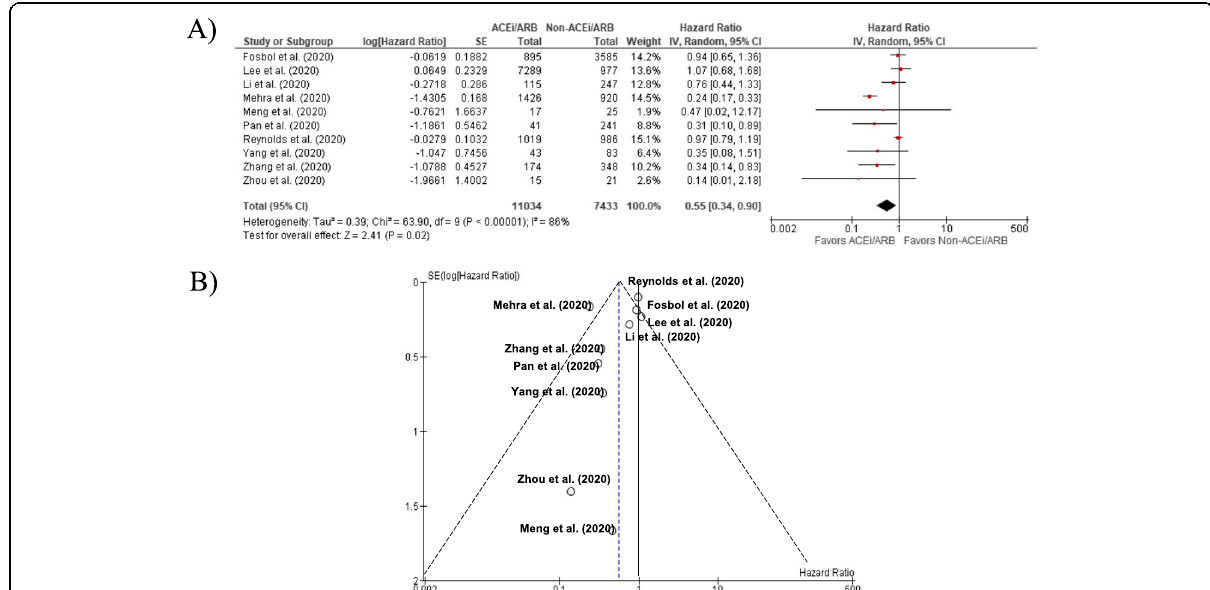
Fig. 2 a Random effects model of pooled hazard ratio comparison: outcome of ACEi/ARB. b Overall estimate of study publication bias scattered in funnel plot